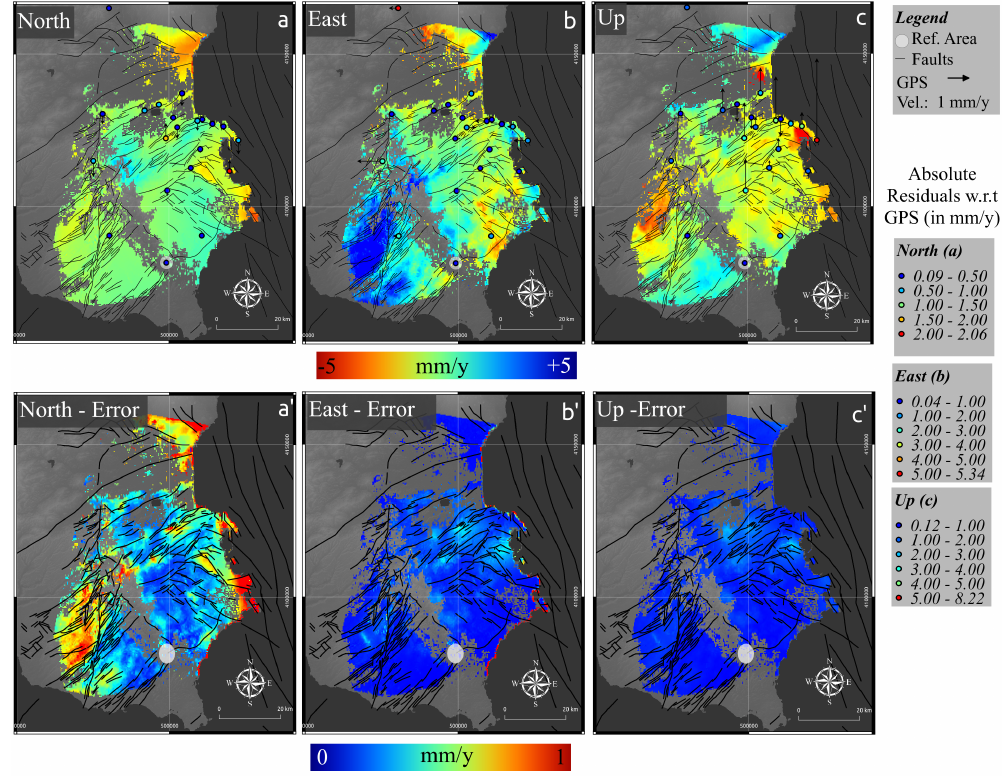
Figure 5. Decomposed velocity field in reference to the Noto GPS station ( a , a’ ) North-South component and WLS error; ( b , b’ ) East-West component and WLS error; ( c , c’ ) Up-Down component (from blue to red) and WLS errors. The corresponding GPS directional velocities have been plotted over the SISTEM output. The colour scale reflects the absolute residual of the GPS component with respect to the SISTEM